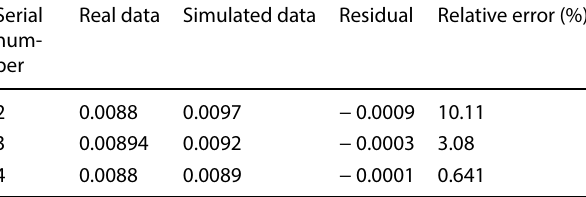
Table 6 Error detection